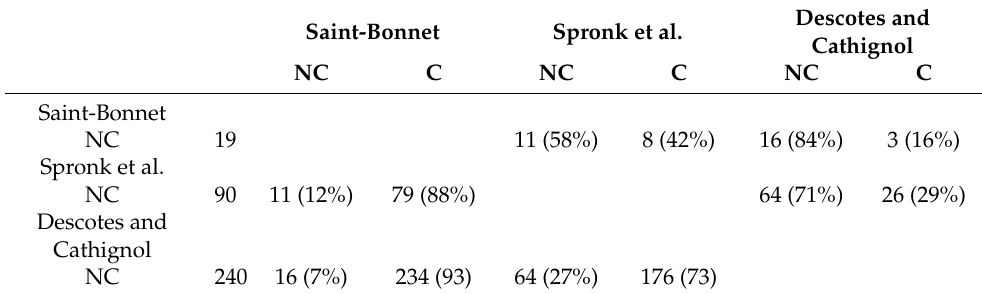
Descotes and Cathignol